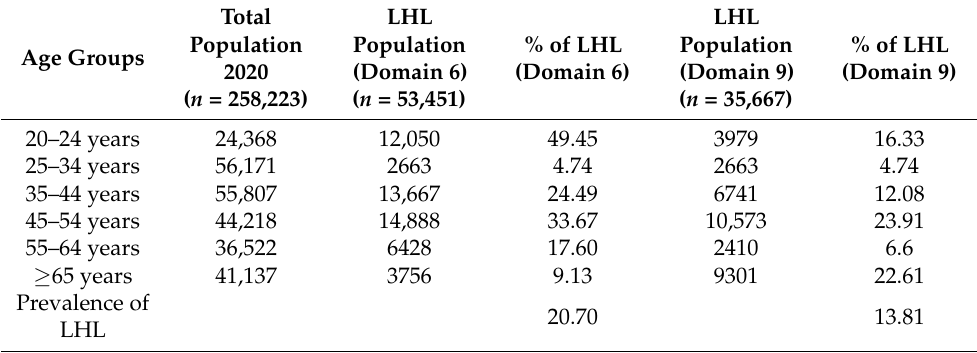
Table 1. The prevalence of LHL in the Blacktown local government area (LGA) by domain (6 and 9).